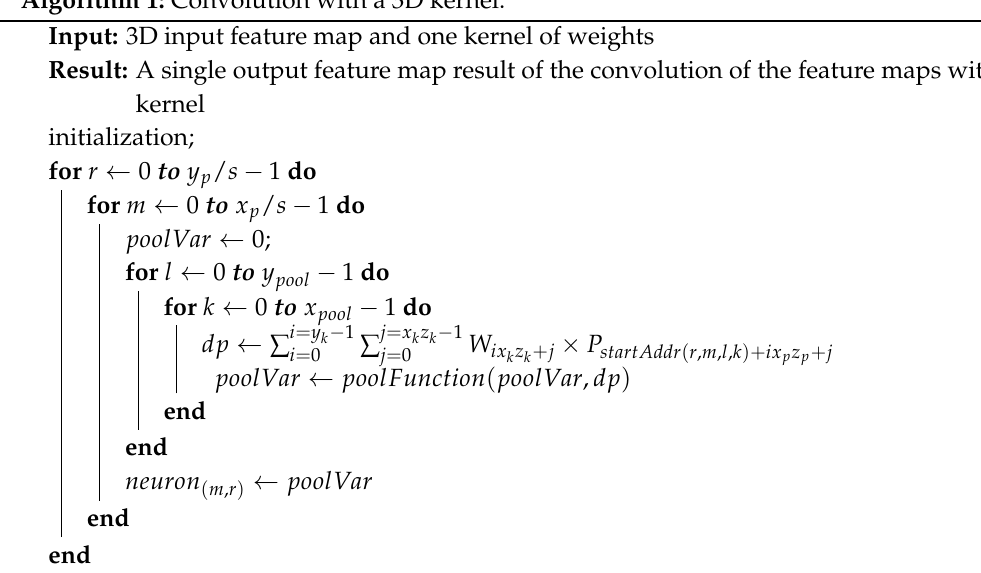
Algorithm 1: Convolution with a 3D